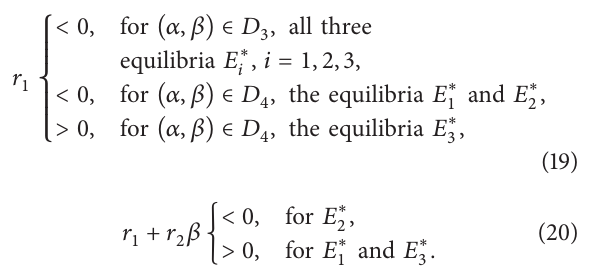
𝛽 > 𝛽 1 or 2 , (ii) two positive equilibria for 𝛽 < 𝛽 < 𝛽 𝛼 = 1/40 , 𝛽 = 0.2599 , and 𝛽 = 0.2782 1 2 . Here, 1 2